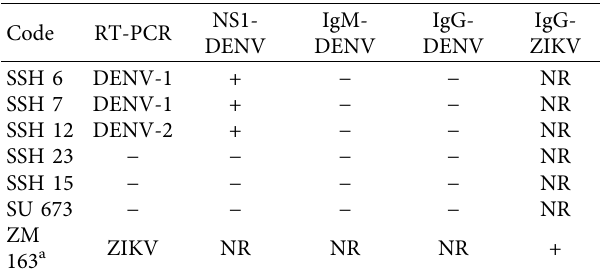
Figure 4: BFA did not improve the focus-forming assay. The three schemes shown at the top of Figure 4(a) and 4(b) were tested in this set of experiments. The first number represents the incubation time without BFA, and the second number is the time when the FFA was revealed, as shown in hpi. (a) Number of FFUs counted in the six wells at the 10 − 4 dilution for each scheme shown. The mean ± standard deviation is presented. ∗∗∗∗ p < 0 . 0001, Mann–Whitney test. (b) Median ± range of the average arbitrary intensity units per FFU evaluated under each condition with the CellProfiler ™ free software. ∗∗ p < 0 . 01, Mann–Whitney test. M: Mock. n � 2 experiments with serial dilutions with 6 replicates for each Table 1: Virological and serological characterization of the clinical samples used.